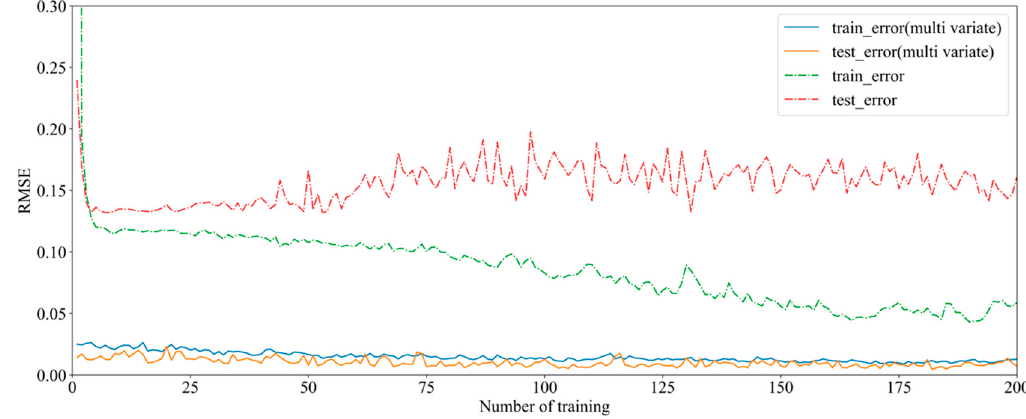
Figure 16. The error of different types of input data.